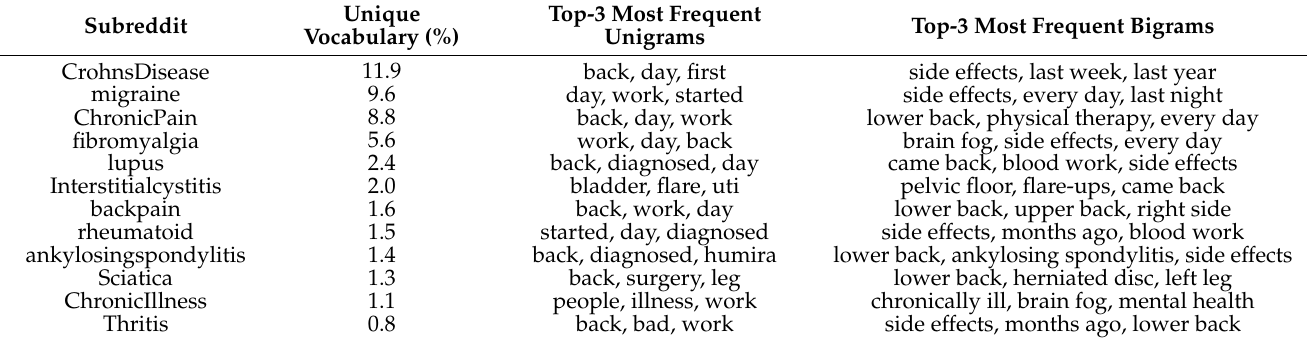
Table A3. Top 3 most frequent unigrams and bigrams per subreddit, along with the percentage of terms which are exclusive to each